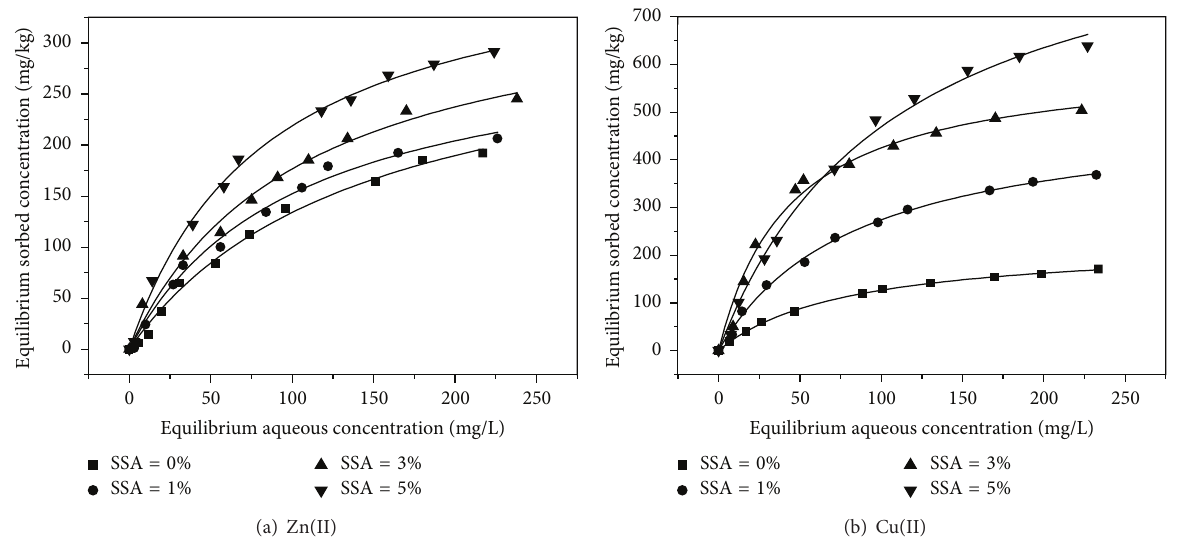
Figure 5: Adsorption isotherms for Zn(II) and Cu(II) on the modified clay containing